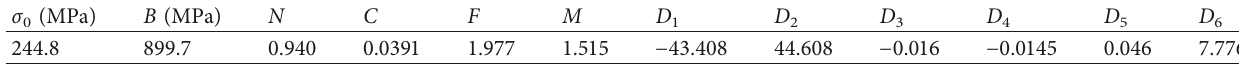
Table 5: Material parameters of modified J-C constitutive model and fracture criterion.